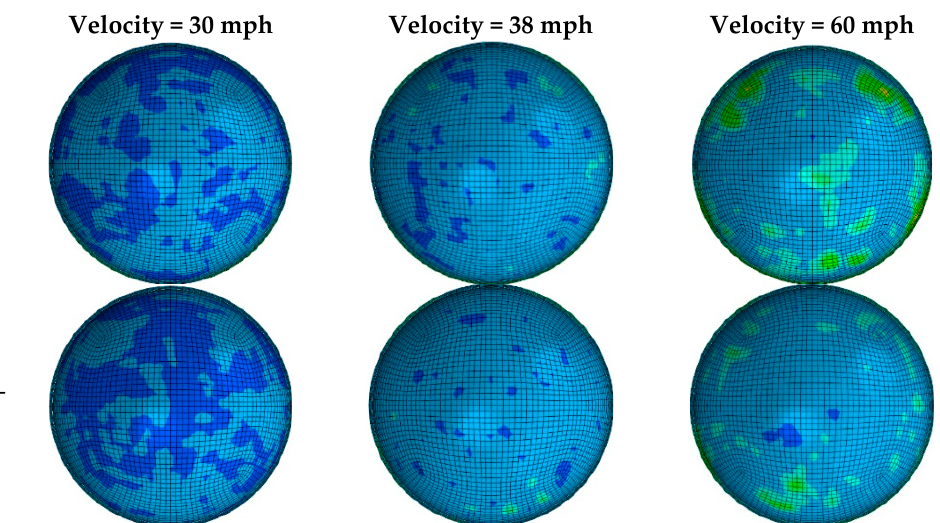
Figure 3. The distribution of von Mises stress in the posterior retina in frontal and diagonal impact scenarios at three different velocities.